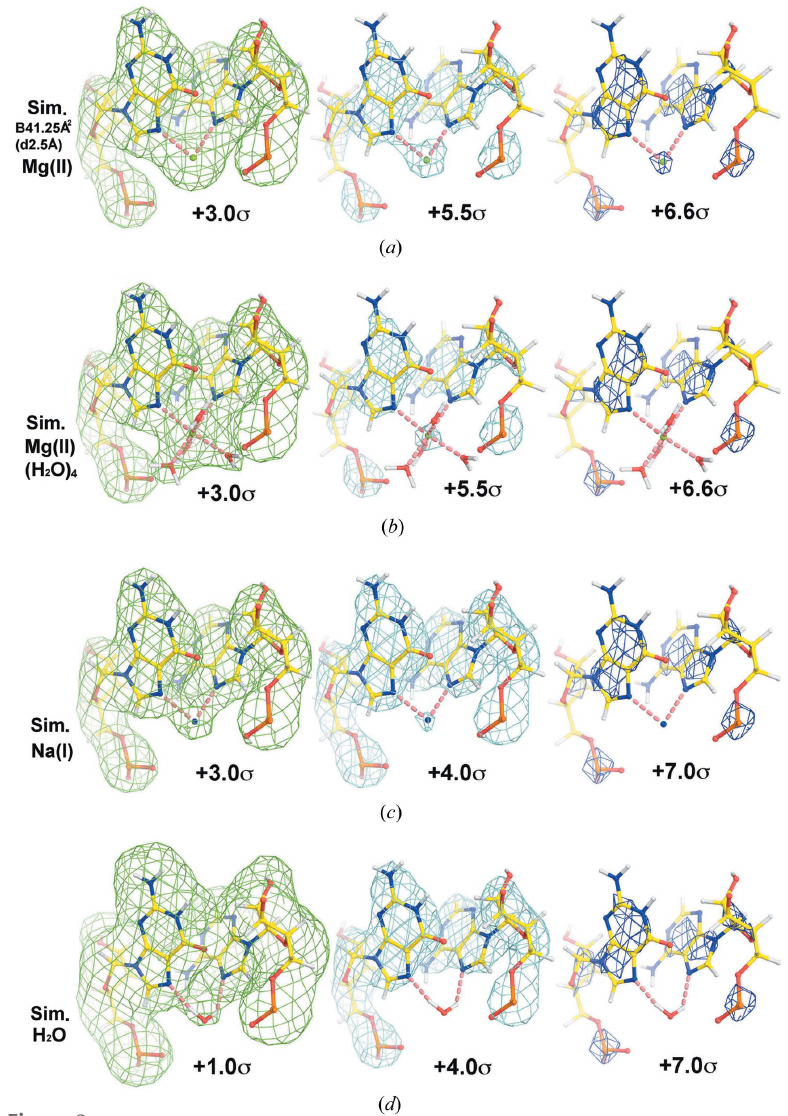
Figure 2 Simulated ESP maps for the Mg-J1 site using atomic models. ( a )–( d ) The model contains either Mg(II) or the [Mg(II)(H 2 O) 4 ] 2+ complex ion, Na(I) or H 2 O, and maps are contoured at three levels as indicated. The Fourier terms were limited to 2.5 A˚ and the mean atomic B factor of 41.25 A˚ 2 was